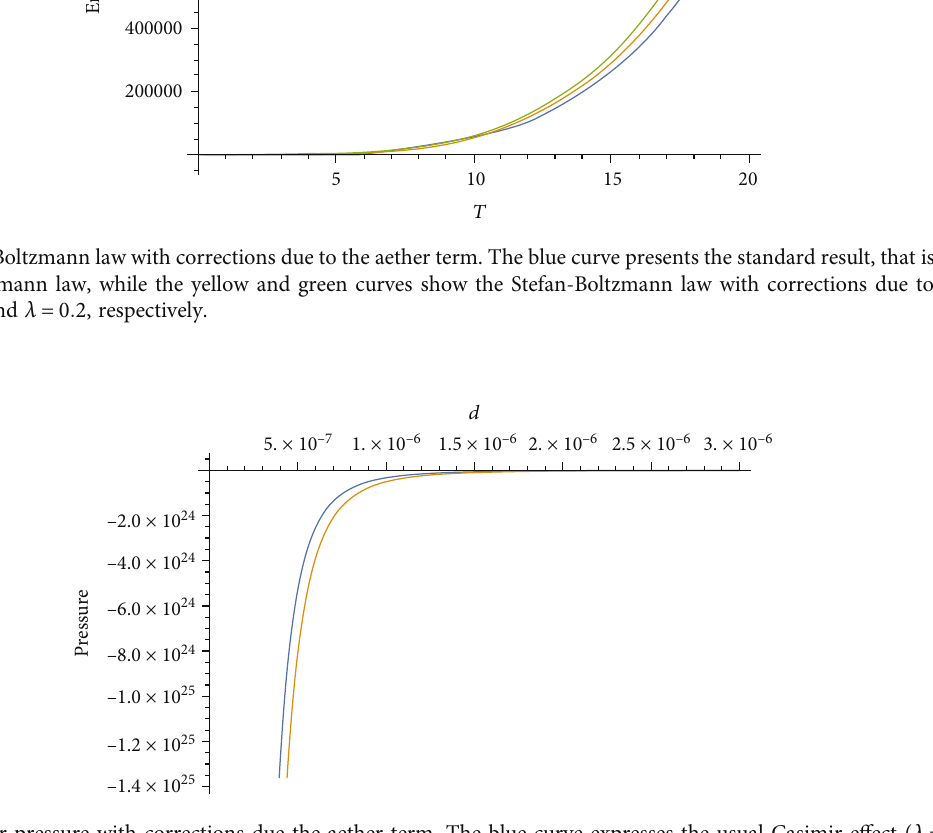
Figure 2: The Casimir pressure with corrections due the aether term. The blue curve expresses the usual Casimir e ff ect ( λ = 0 ), and the yellow curve shows the corrections to the Casimir pressure for the Lorentz violation case, considering λ = 0 : 8 (this is a theoretical choice to better visualize the modi fi cations caused by the aether term).